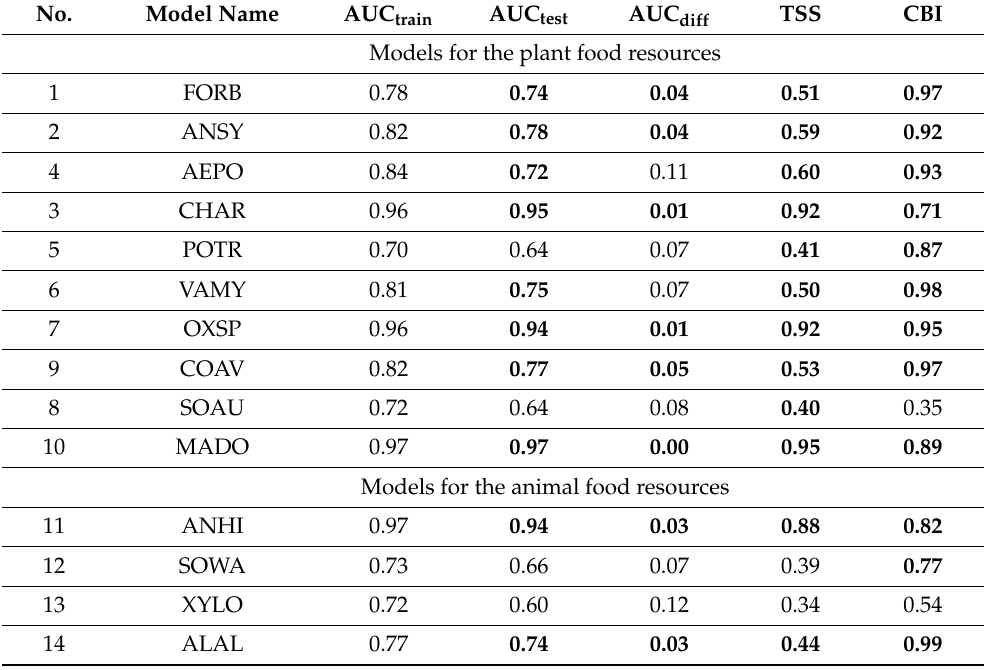
Table 3. Evaluation of 14 food-probability models for the brown bear in the Central Forest State Nature Reserve (West-European Russia) in 2008–2020. Model accuracy metrics included area under the receiver operator curve for: training data (AUC train ), testing data (AUC test ), difference between them (AUC diff ), true skill statistic (TSS), and continuous Boyce index (CBI). All values, except CBI, represent means from 10-fold block cross-validation. Model accuracy with CBI was assessed on the independent withheld test datasets. Values above the thresholds for AUC test (0.7), AUC diff (0.05), TSS (0.4), and CBI (0.7) are in